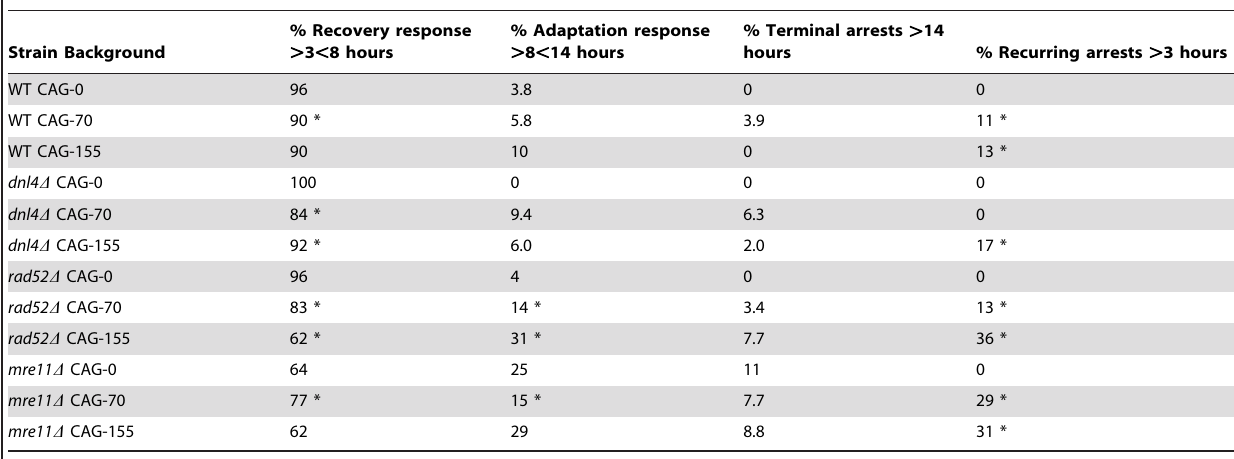
Table 1 . Modes of exit from cell cycle arrest.